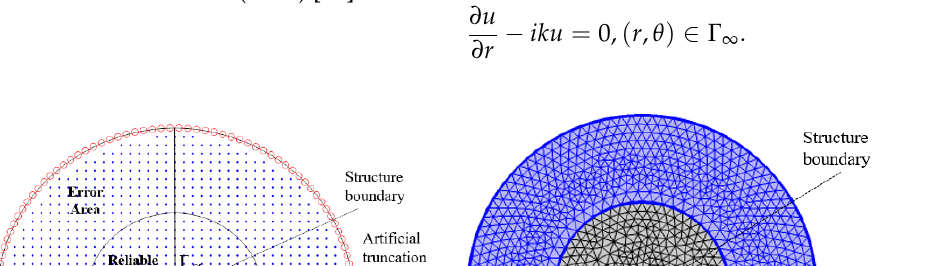
Table 2. Numerical errors (L 2 ) in reliable region obtained by the FEM + ABC (COMSOL) with re- spect to the increasing element number and wavenumber.